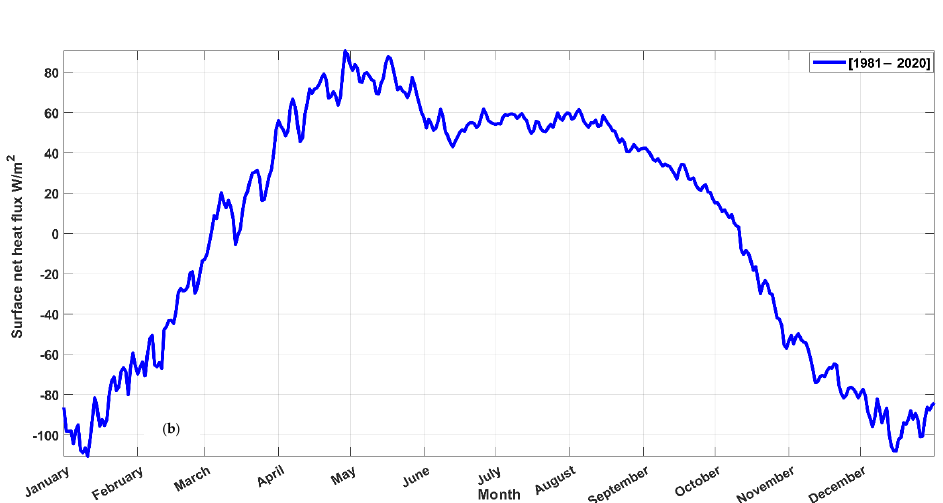
Figure 5. ( a ) Annual surface net heat flux (W/m 2 ) time series for the Red Sea is denoted by a continuous black line from 1981 to 2020, while the surface net heat flux trend is represented by a continuous red line. ( b ) Temporal evolution of the daily basin averaged surface net heat flux (W/m 2 ) from 1981 to 2020 for the Red Sea.